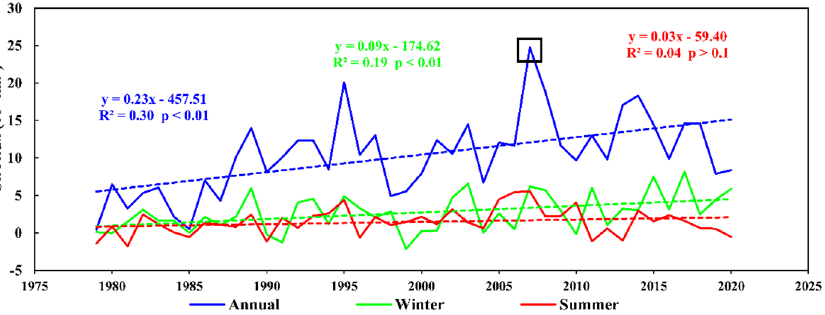
Figure 8. The annual and seasonal SIA fluxes between the Pacific and Atlantic sectors in